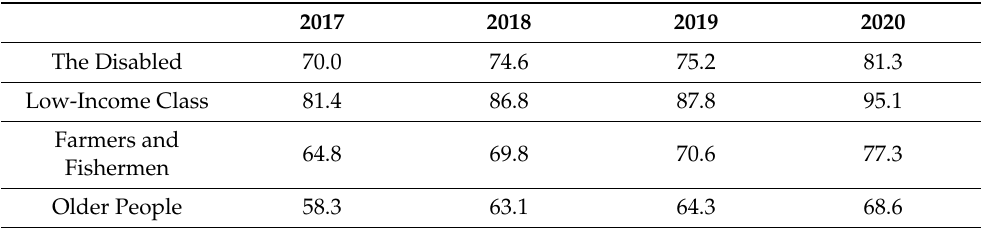
Table 3. Digital Informatization Level of Four